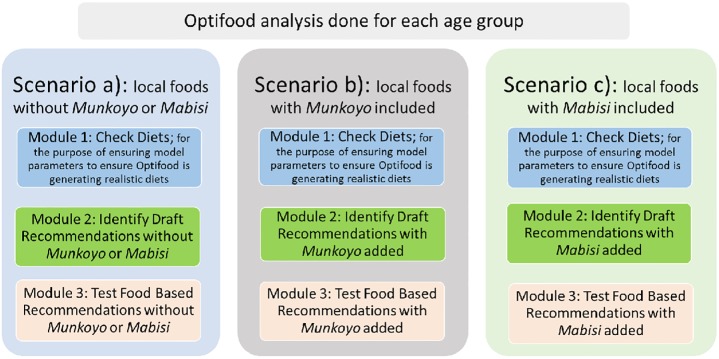
Graphical representation of Optifood analysis.Each age group was done separately and for each age group three scenarios were done. For each scenario, the three modules were applied to determine the FBRs.